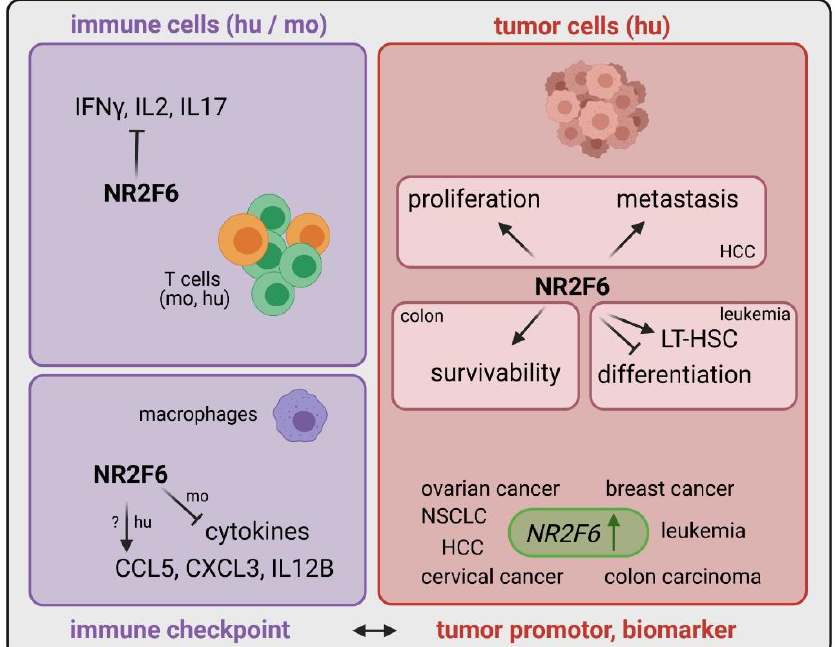
Figure 1. The dual role of NR2F6 in the immune system and tumor cells. In lymphocytes such as T cells (mouse and human), NR2F6 regulates the expression of cytokines such as IFNγ, IL2 and IL17 in an inhibiting manner reminiscent of an immune checkpoint. A similar mechanism of transrepression can be found in murine macrophages. However, apparently, NR2F6 may exert a functionally opposite transactivation role in human macrophages. Cytokine inhibition of immune cells reflects a tumor-promoting property. Moreover, and remarkably, upregulation in several human cancer cells such as ovarian, breast, cervical, colon, hepatocellular, non-small cell lung cancer and leukemia represents a prospective biomarker. In tumor cells, NR2F6 appears to be important for proliferation, metastasis, survivability of tumor cells and long-term hematopoietic stem cells (LT-HSC), whereas it inhibits differentiation processes in leukemic cells—all of which are tumor-promoting properties. In view of the dual pro-tumor activity of NR2F6 in immune cells and tumor cells, inhibition of NR2F6 offers the unique therapeutic potential to improve current treatment outcomes.